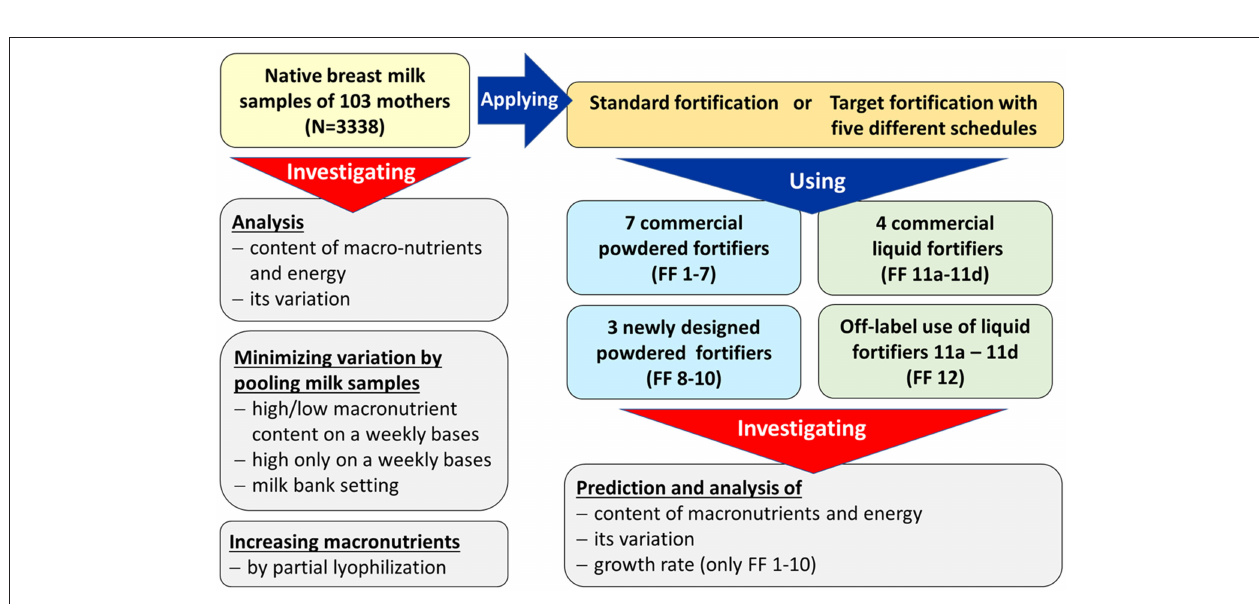
FIGURE 1 | Macronutrient content in native breast milk, standard fortified and target fortified breast milk. Lines represent recommended macronutrient contents of 4.4g fat, 8.8g carbs, and 3.0g protein per 100mL to reach ESPGHAN recommended intakes assuming an average fluid intake of 150 mL/kg/d leading to a total daily intake of 6.6, 13.2, and 4.5 g/kg/d for fat, carbs, and protein, respectively. BM, native breast milk; Carbs, carbohydrates; SF, standard fortification; TFO, target fortification. Under certain conditions single nutrient levels can exceed ESPGHAN recommendations already after standard fortification.